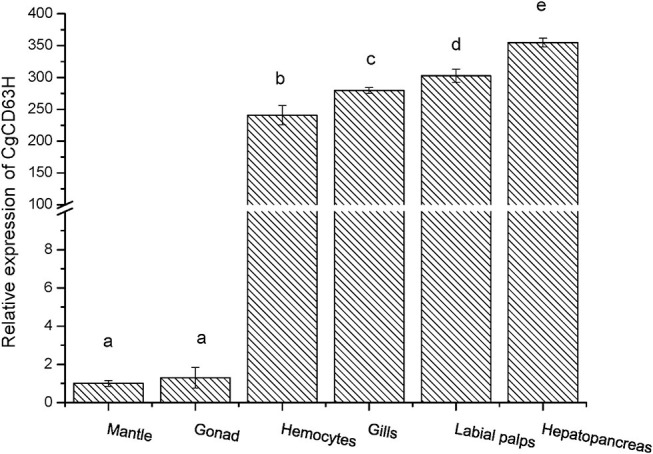
Tissue distribution of the CgCD63H transcripts. CgCD63H relative messenger RNA (mRNA) expression level in mantle, gonad, hemocytes, gills, labial palps, and hepatopancreas was normalized to that of CgEF1-α. Each value was shown as mean ± SE (N = 6), and bars with different letters were significantly different (p < 0.01).